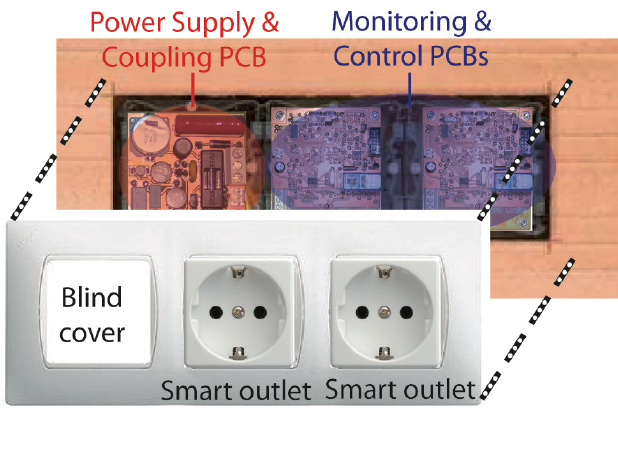
Figure 7. Boards and functional blocks to install the smart sensor inside a Schuko